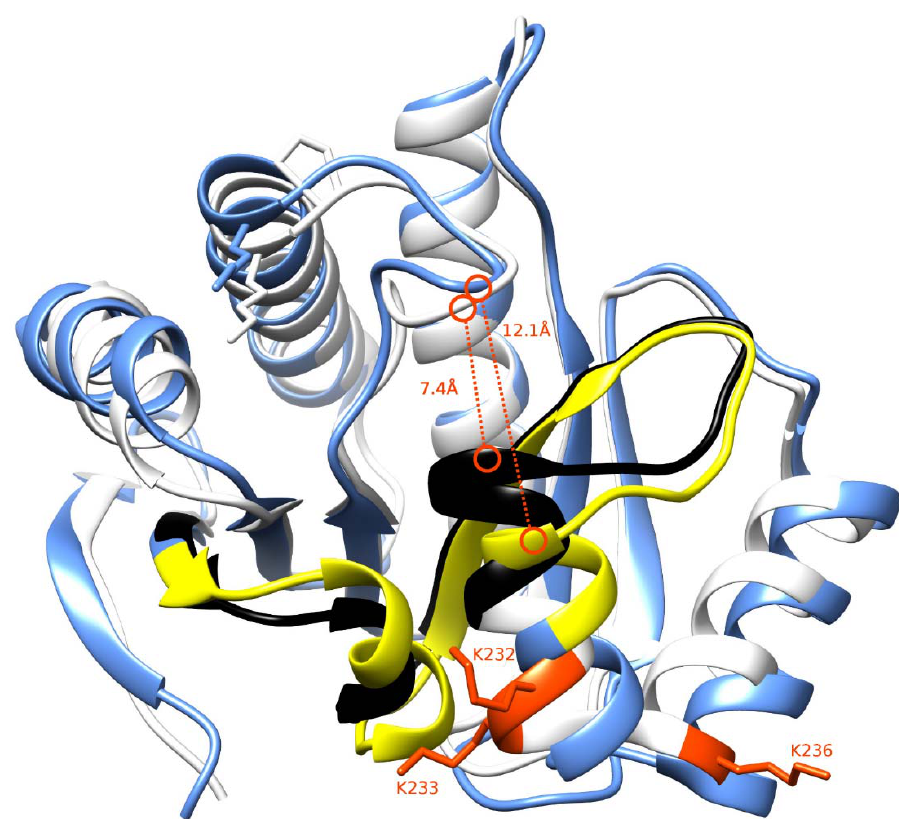
Figure 6. Three-dimensional structures of macroH2A1.1 and macroH2A1.2. The structures of Figure 6. Three ‐ dimensional structures of macroH2A1.1 and macroH2A1.2. The structures of macroH2A1.1 and macroH2A1.2 are drawn in white and light blue, respectively. The region macroH2A1.1 and macroH2A1.2 are drawn in white and light blue, respectively. The region showing sequence difference between the two proteins (198–229) has been highlighted in black for showing sequence difference between the two proteins (198–229) has been highlighted in black macroH2A1.1 and yellow for macroH2A1.2. The residues K232, K233, and K236 have been marked for macroH2A1.1 and yellow for macroH2A1.2. The residues K232, K233, and K236 have been in red. The binding pocket’s width has been highlighted with a dashed red line reporting the marked in red. The binding pocket’s width has been highlighted with a dashed red line reporting the measure in Å ngstroms. measure in